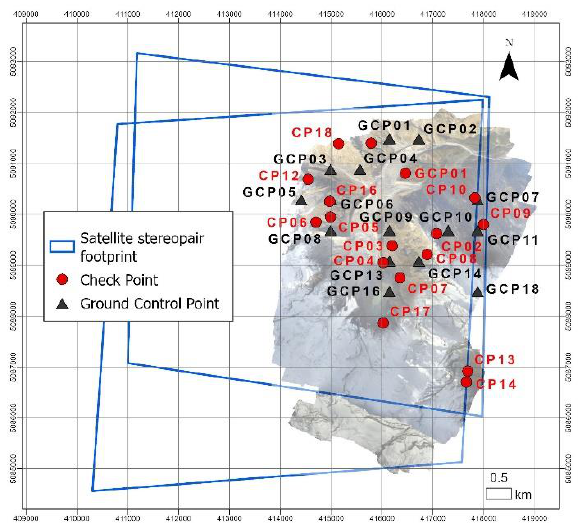
Figure 3. Distribution of GCP e CP (respectively used for image orientation and accuracy validation) .